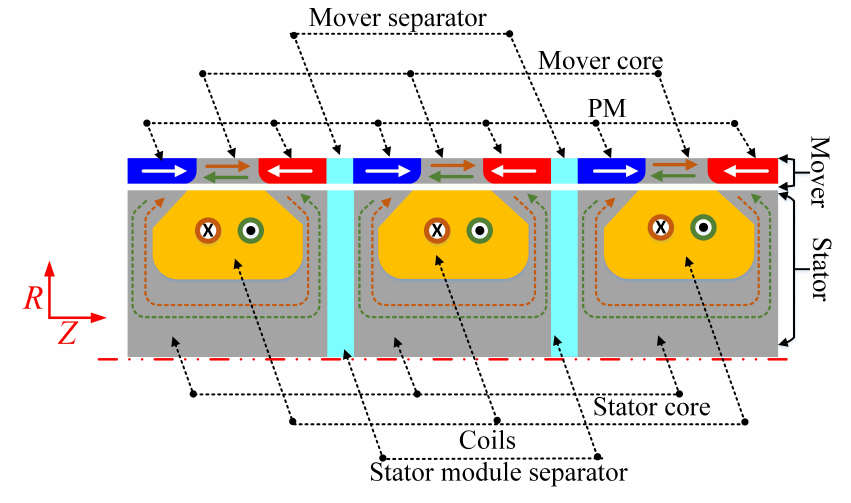
Figure 1. Design of the proposed TMM-LOA.